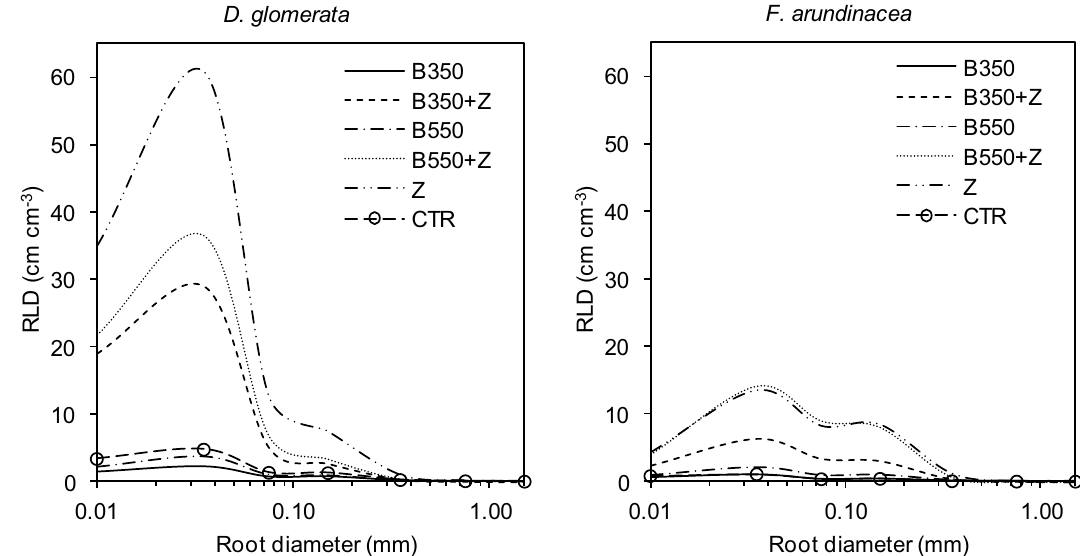
Figure 4. Root length density (RLD) distribution at the different root diameter values for treatments with different soil organic amendments. Treatments: zeolite (Z), biochars (B350 and B550), mixtures of biochars and zeolite (B350 + Z and B550 + Z), control (CTR).